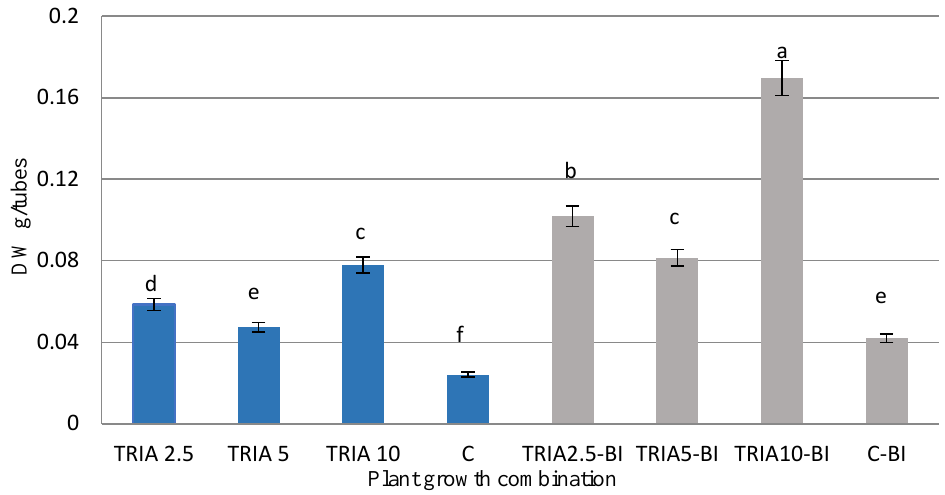
Figure 3. Effect of TRIA on dry mass (DW) of D. forrestii shoots, growing five weeks on MS medium containing TRIA (µg/L) or TRIA (µg/L) and 0.5 mg/L BAP and 0.2 mg/L IAA (TRIA-BI): C-medium without growth regulators, C-BI- medium with 0.5 mg/L BAP and 0.2 mg/L IAA. The values represented means ± SE of three independent experimental replicates. The means marked with various letters for the same parameter were different at p < 0.05 according to a Tukey’s test.